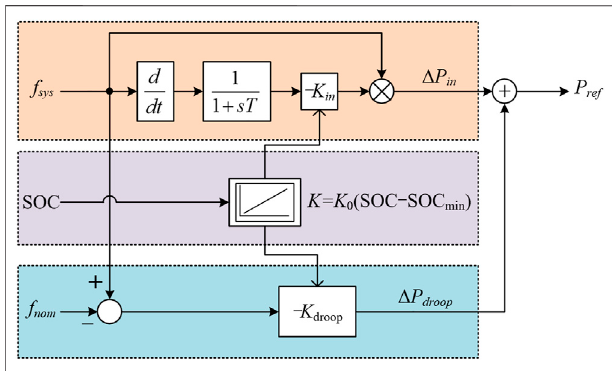
FIGURE 4 | Proposed combined inertial control strategy of the BESS with an adaptive control coef fi cient.